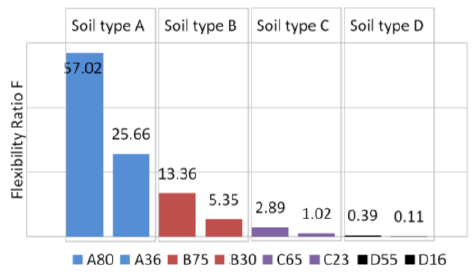
Figure 5. Flexibility ratios for the eight models studied in the equivalent visco-linear elastic analyses.